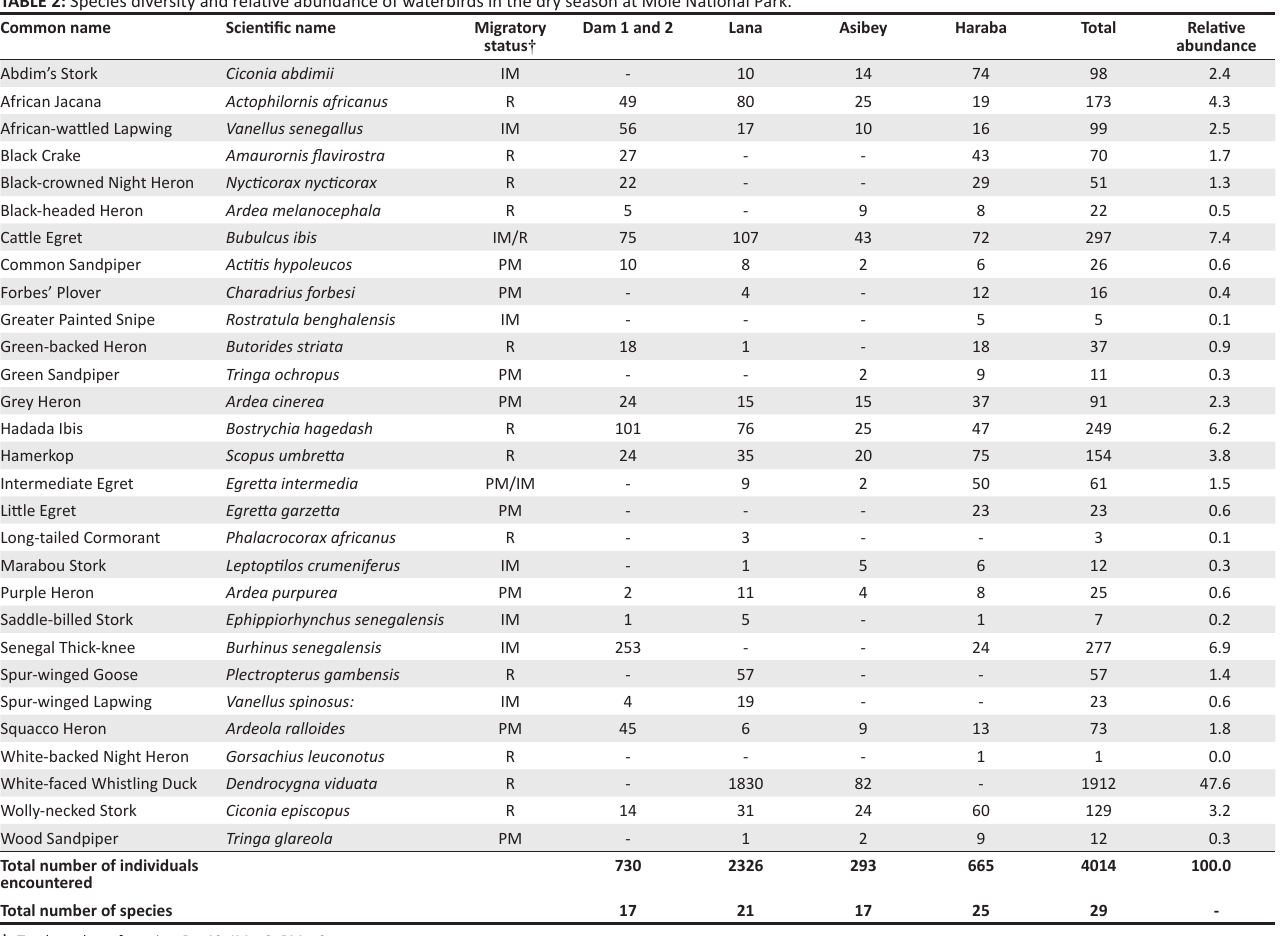
TABLE 2: Species diversity and relative abundance of waterbirds in the dry season at Mole National Park. Common